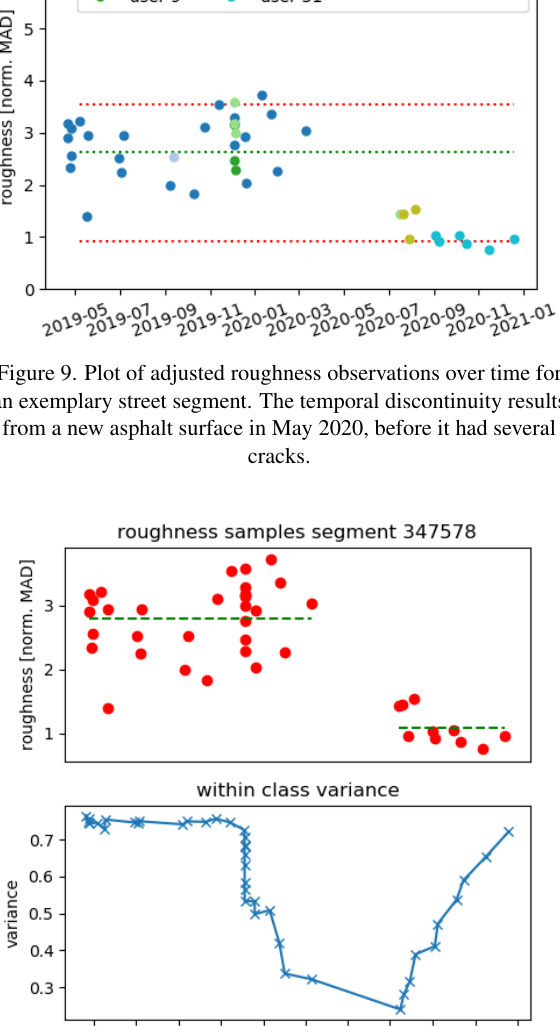
Figure 10. Example of an automatic change detection via Otsu segmentation in segment of Figure 9.